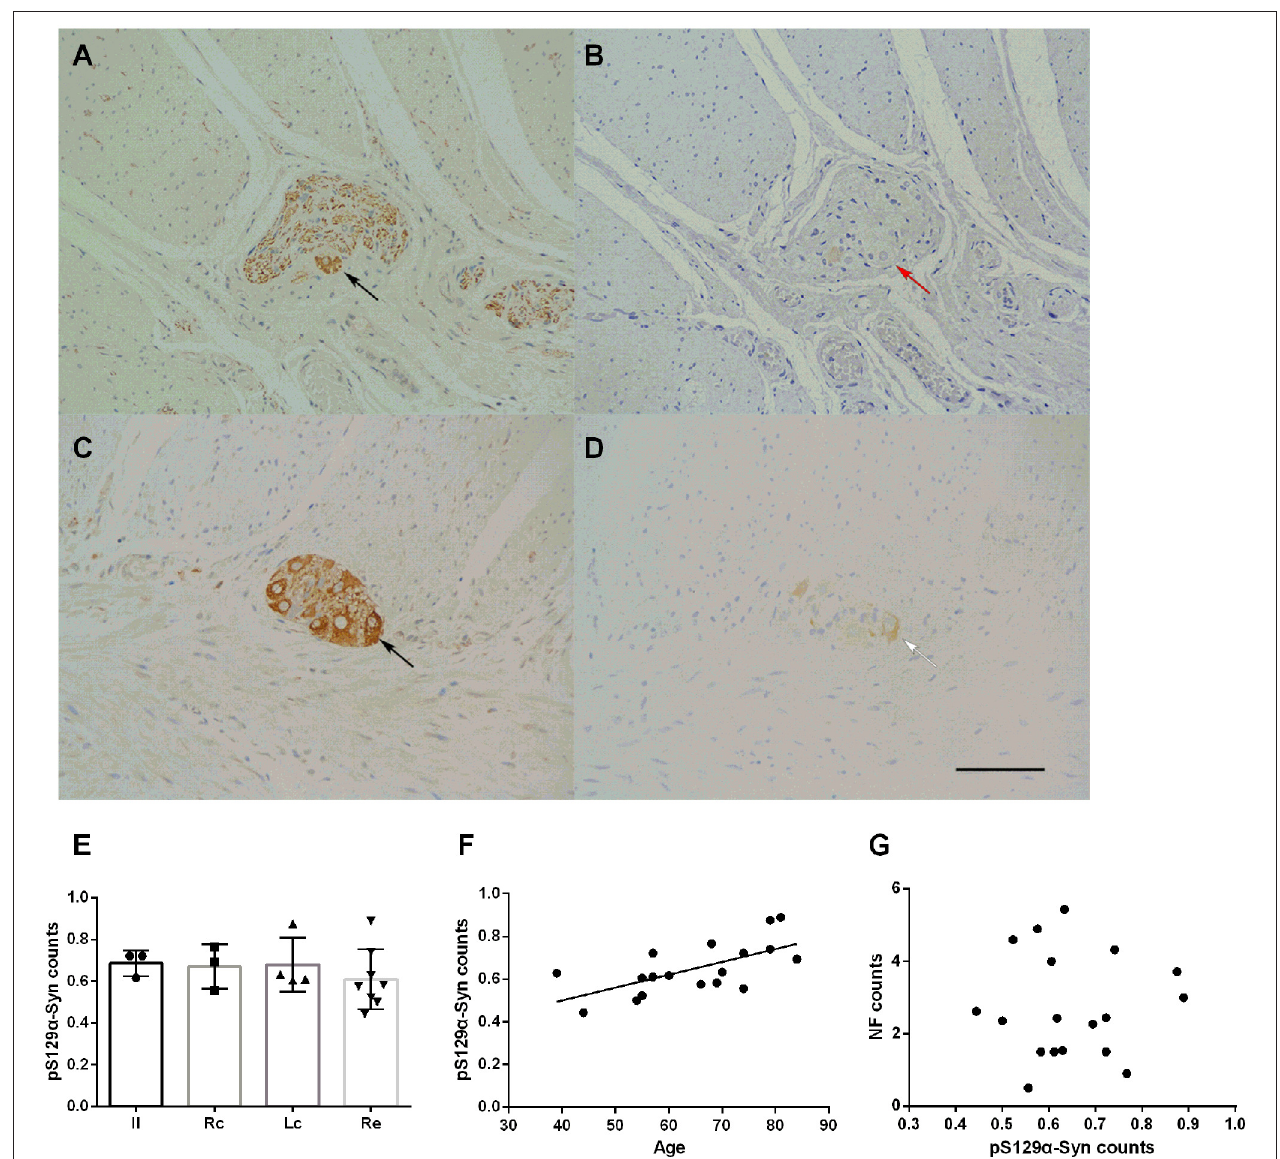
FIGURE 4 | Characteristic of p S129 α -Syn immunoreactive signals in the myenteric plexus (A–D) . Representative image of NF immunoreactivity in the myenteric plexus (black arrows in A,C ). p S129 α -Syn immunoreactivity in the human myenteric plexus (B,D) (brown color). Co-localization of NFs and p S129 α -Syn (white arrow in D ). Not all neurons with positive NF staining have p S129 α -Syn deposition (red arrow in B ). Hematoxylin counterstain, bars = 50 µ m. (E) Quantitative analysis of the p S129 α -Syn-positive count in the myenteric plexus. Specimens were subdivided into the Ileum(Il), right colon (RC), left colon (LC), and rectum (RE). Inter-group differences are reported as per one-way ANOVA ( F = 0.452, df = 17, p = 0.720) followed by LSD-t post-hoc test. Data are shown as p S129 α -Syn positive neurons per visual field for individual cases and the group mean ± SD is also shown. (F) Scatter plot of the p S129 α -Syn-positive neuron count within the myenteric plexus with age showed a positive correlation (Pearson correlation, R = 0.643, p = 0.004). (G) Scatter plot of p S129 α -Syn immunoreactive signals within the myenteric plexus with the NF-positive neuron count. No significant correlation was observed (Pearson correlation, p =